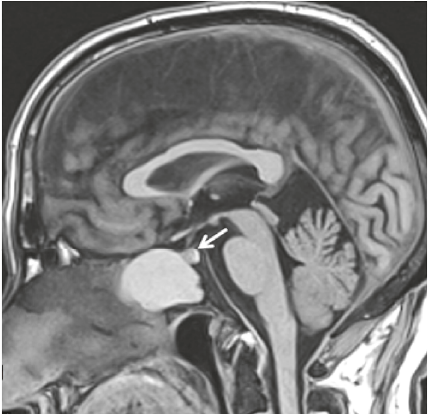
Figure 2: T1-weighted RMI in sagittal cut showing expansive cystic mass occupying the sphenoid sinus and posterior ethmoid. Observe the integrity of pituitary gland (white arrow).